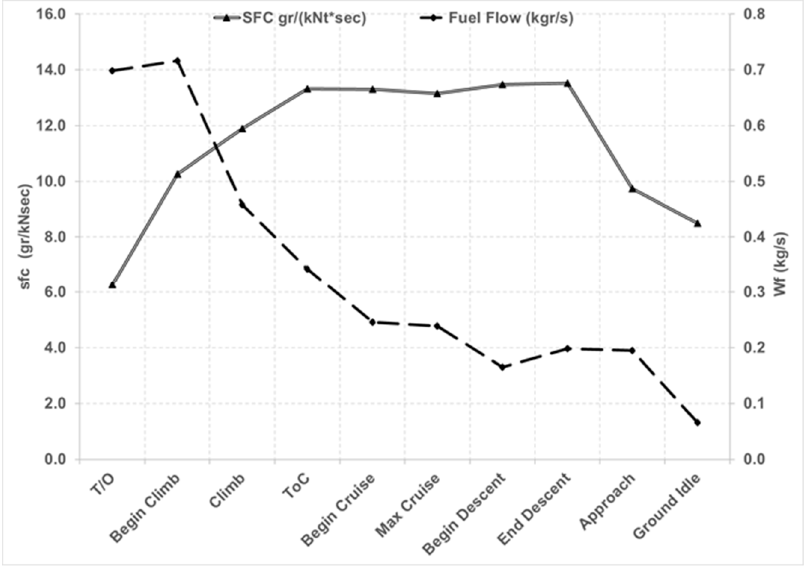
Figure 7. SFC and fuel flow at different flight phases.